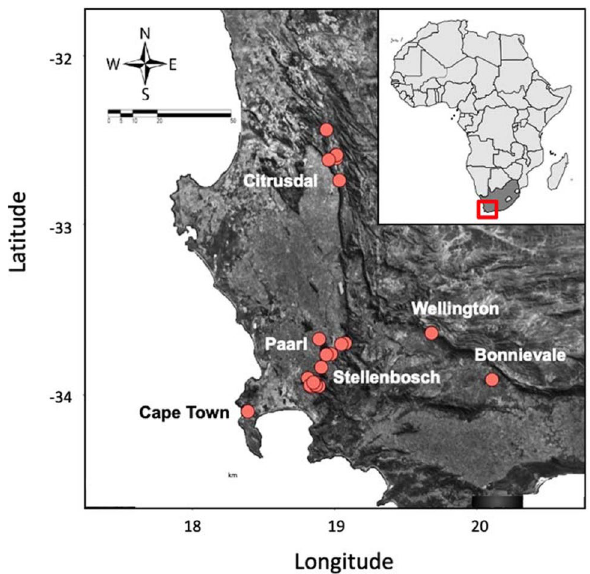
Figure 7. Sampled sites where the seasonal dynamics of Bactrocera spp. and their parasitoids were monitored (2004–2007) on wild olives in the Western Cape, South Africa. The map was created in R (version 3.6.3, www.r- proje ct.org) using “get_map” wrapper from “ggmap” package (version 3.0.0, https ://cran.r-proje ct.org/web/packa ges/ggmap /ggmap .pdf), which queries with Google Maps server to produce static maps 69